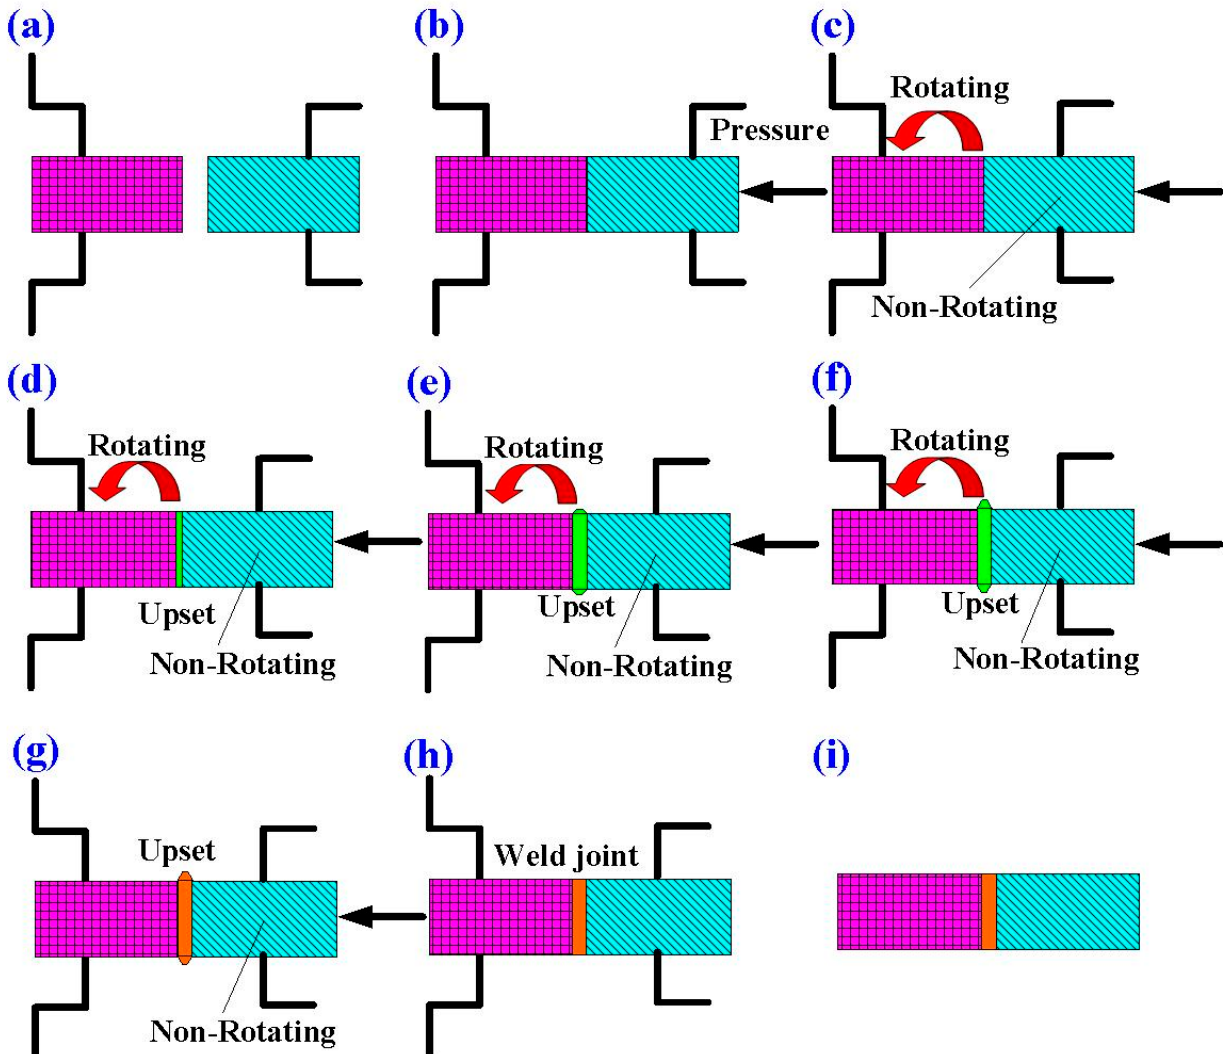
Figure 3. Schematic illustration of FRW process. ( a ) preparing two FRW specimens, ( b ) applying pressure to force FRW specimens into contact, ( c ) rotating one of the FRW specimens, ( d ) initial stage of FRW, ( e ) middle stage of FRW, ( f ) final stage of FRW, ( g ) FRW is completed, ( h ) the weld bead is processed, and ( i ) FRW is